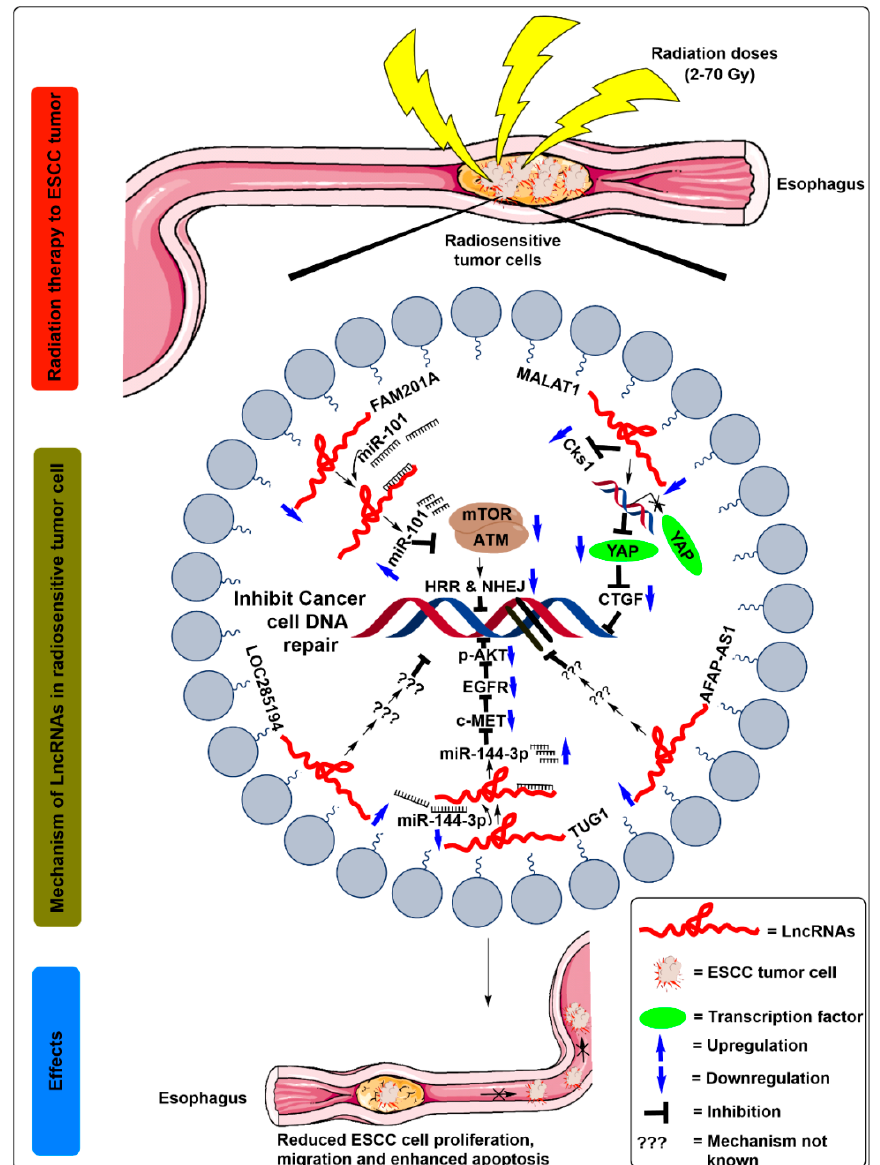
Figure 3. Schematic illustration of the molecular mechanisms of lncRNAs in the regulation of radiosensitivity in ESCC treatment. After radiation exposure to the ESCC cells, miR-101 binds to downregulate lncRNA FAM201A . Moreover, the expression of miR-101 was increased after binding to the FAM201A , which is followed by downregulated expression of mTOR and ATM, which decreases the homologous recombination repair (HRR) and non-homologous end joining (NHEJ) pathway and thus promotes the breakdown of double-strand DNA of ESCC cells. After radiation exposure to the ESCC cells, MALAT1 expression was decreased, which further inhibits Cks1 levels at both mRNA and protein levels. In addition, it also decreased YAP’s translational activity, reducing the expression levels of connective tissue growth factor (CTGF), thus enhancing the breakdown of the double-strand DNA in ESCC cells. After radiation exposure to the ESCC cells, downregulated expression of lncRNAs LOC285194 and AFAP-AS1 inhibits DNA repairing of ESCC cells. After radiation exposure to the ESCC cells, miR-144-3p competes with binding to the downregulated lncRNA TUG1. Moreover, the expression of miR-144-3p was increased after binding to the TUG1, which is followed by downregulated expression of c-MET, EGFR, and p-Akt protein, which ultimately promotes the breakdown of double strand DNA of ESCC cells and confers radiosensitivity.